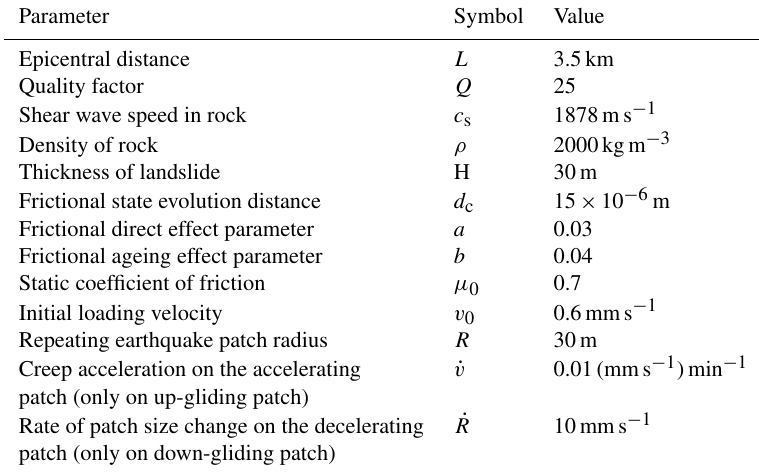
Table 1. Parameters of the stick-slip